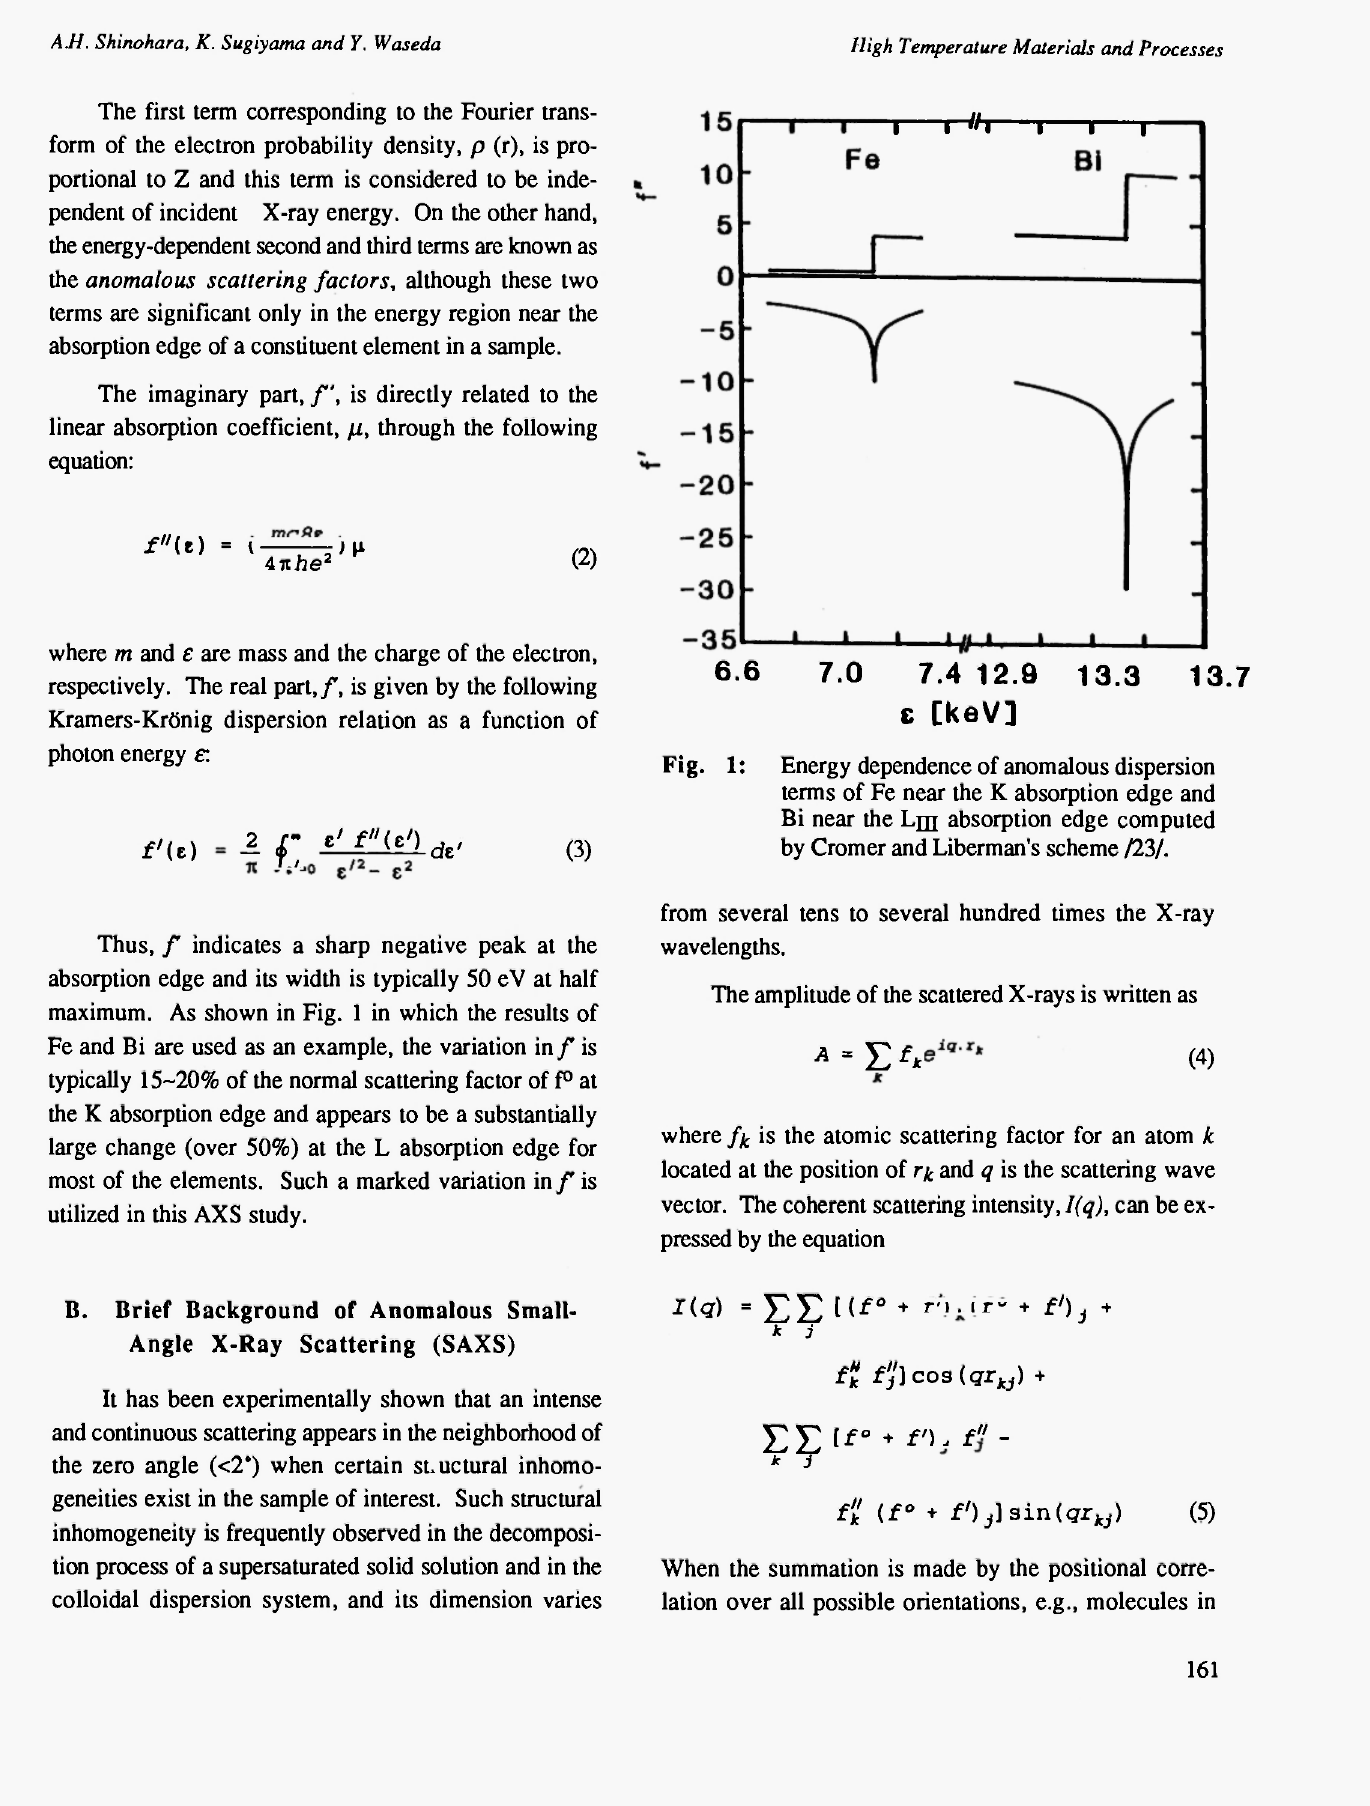
Fig. 1: Energy dependence of anomalous dispersion terms of Fe near the Κ absorption edge and Bi near the Lm absorption edge computed by Cromer and Liberman's scheme